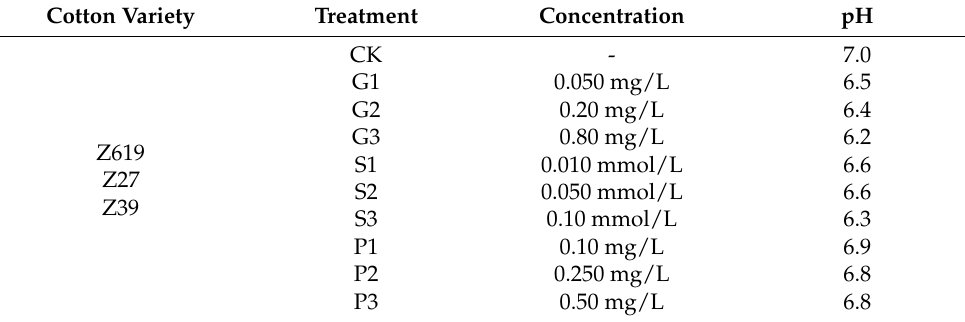
Table 2. Treatments in the